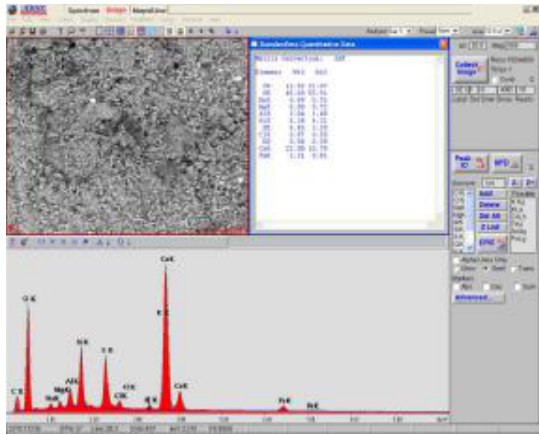
Figure 5: The Analysis of the second sample with EDAX